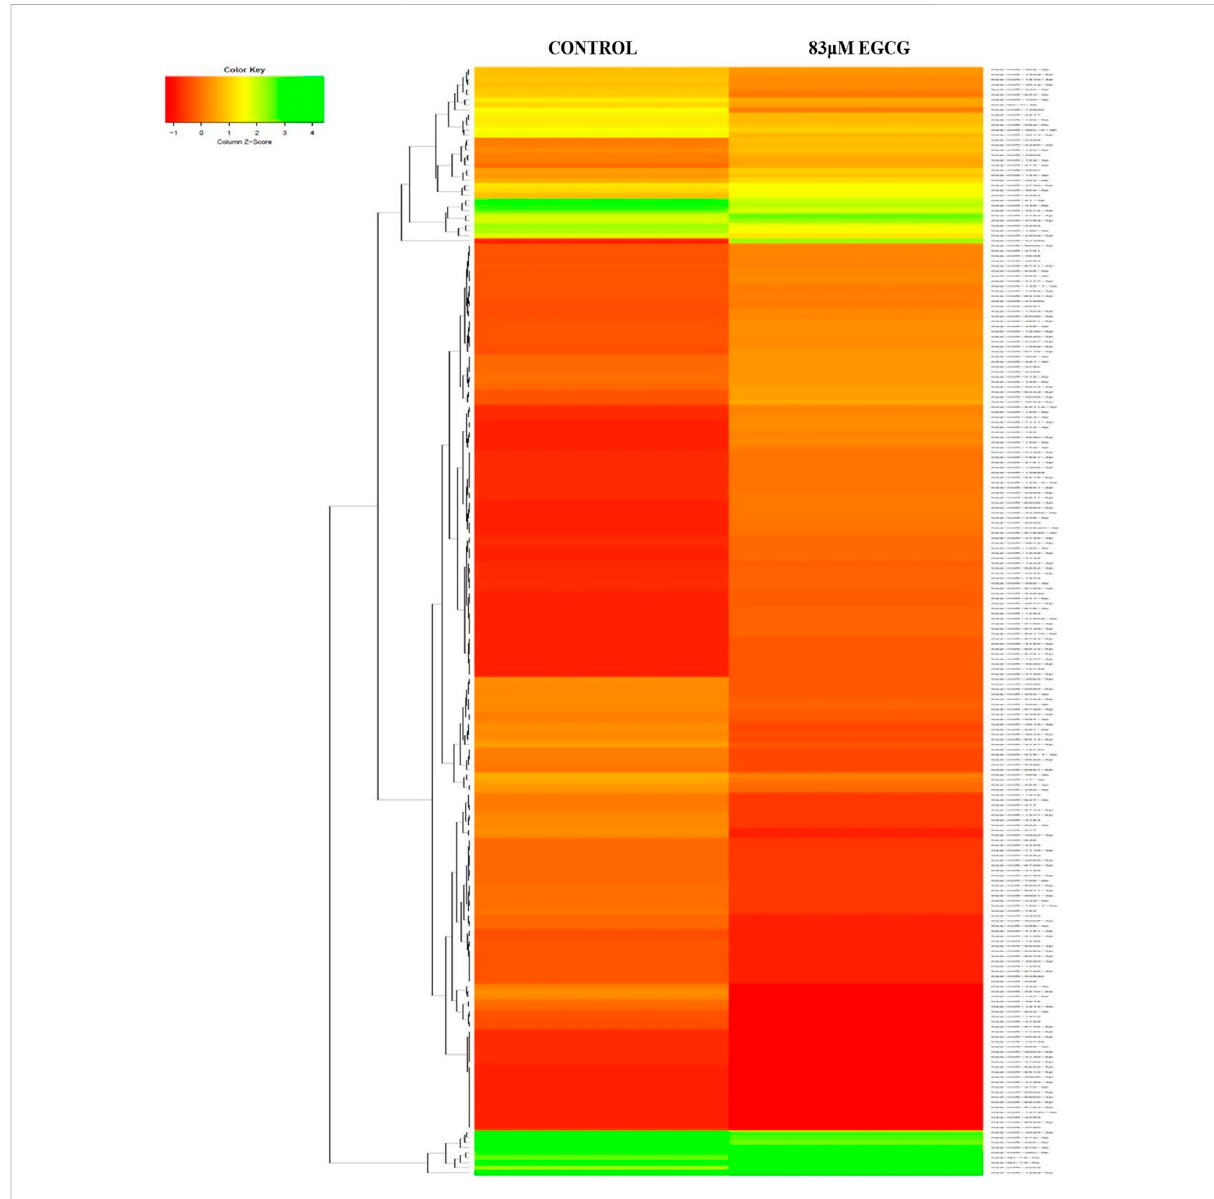
FIGURE 6 Theexpressionpro fi lesofknownmicroRNAsintheuntreatedcontrolMDA-MB-231cellsand24 hof83 μ MEGCGtreatedcells.Colorkey-red: up-regulation, green: down-regulation, and yellow: neutral expression.